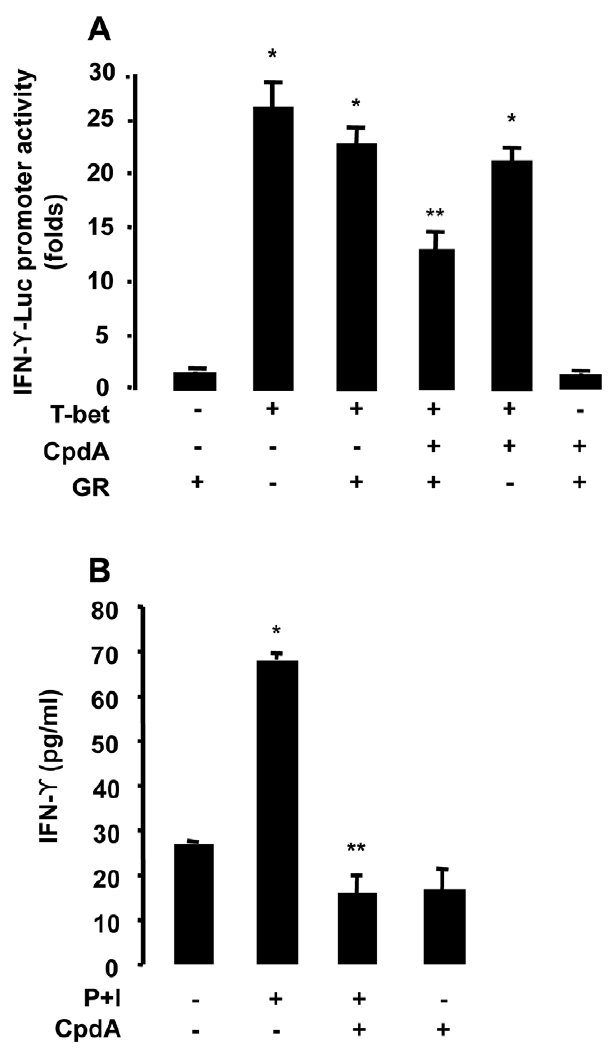
Figure 3. Compound A inhibits IFN- c promoter activity and cytokine production. A, EL4 cells were cotransfected with 9 m g of IFN- c promoter-driven luciferase plasmid (IFN- c -Luc) plus 9 m g of GR expression vector and with 9 m g of T-bet expression vector. After 16